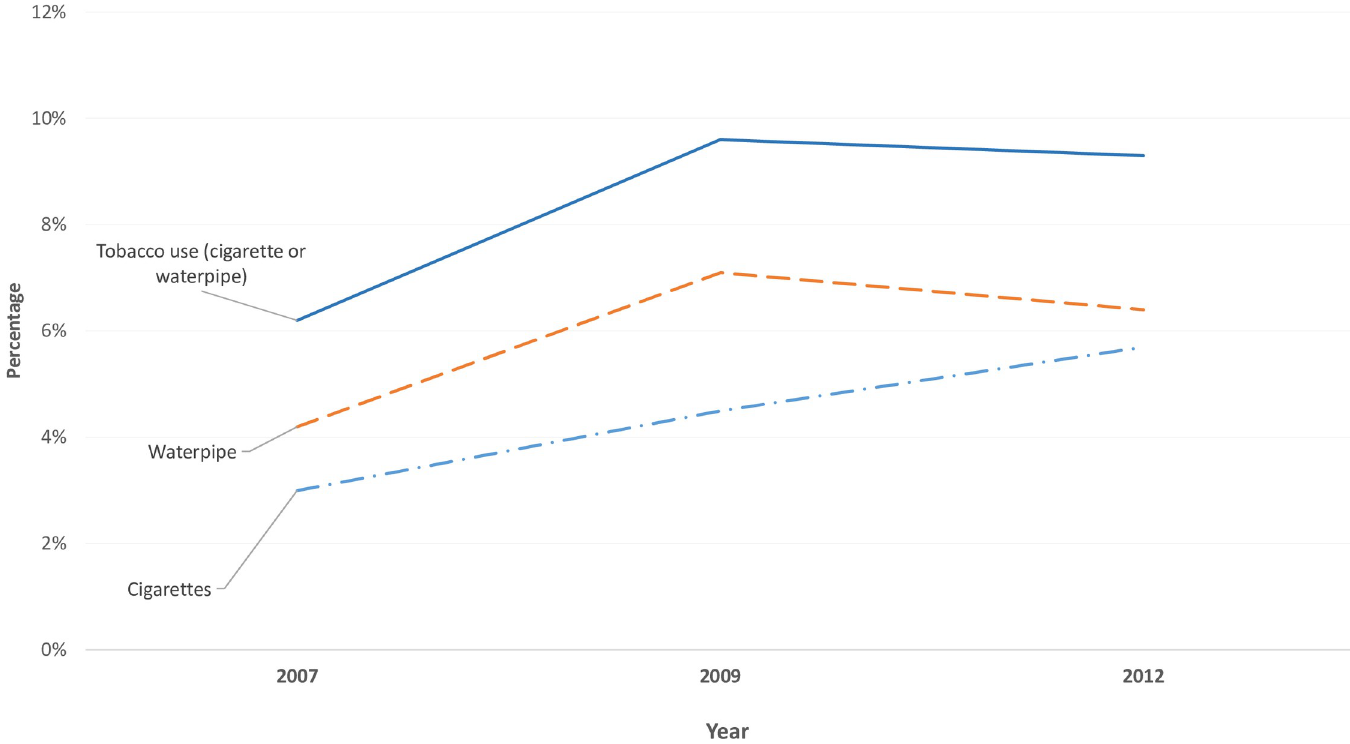
Fig 2. Prevalence estimates of cigarette smoking, waterpipe use, and tobacco use (regardless of type) among ever-married pregnant women between 2007 and